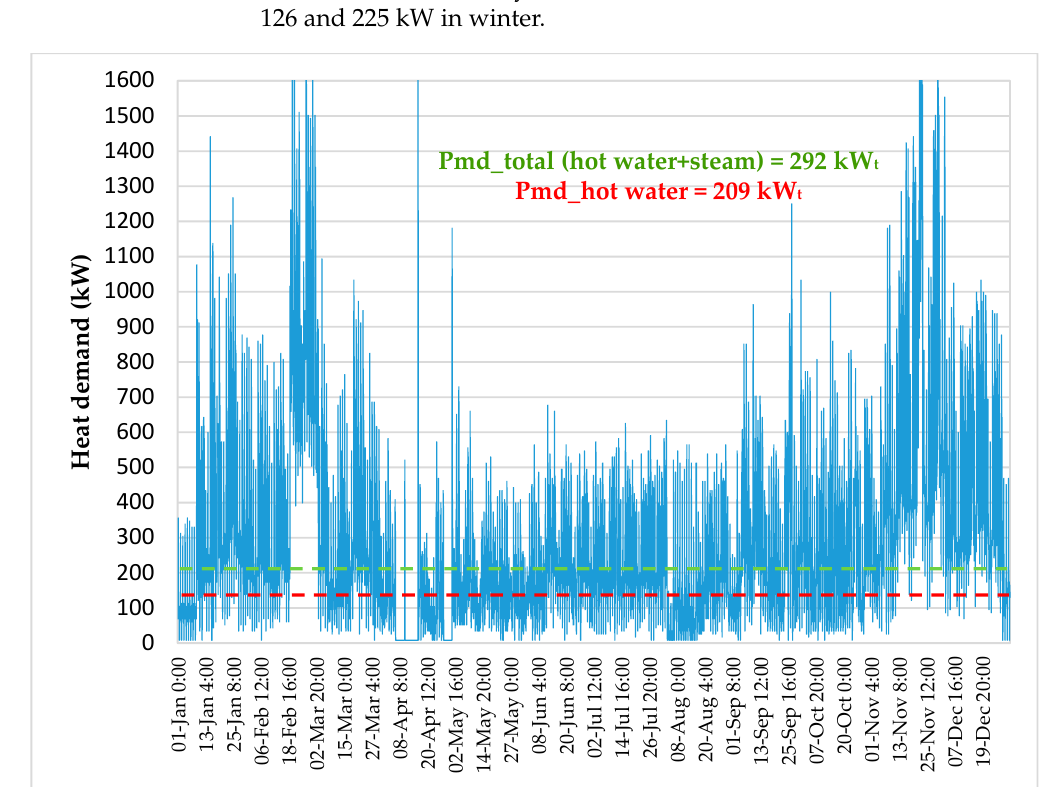
Figure 9. Seasonal variation in the heat demand.